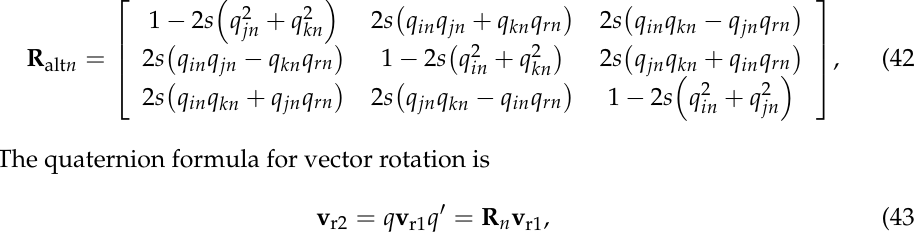
where the output vector is v r2 and the input vector is v r1 . If v r1 = ( 0, 0, 1 ) then the first segment’s orientation vector is